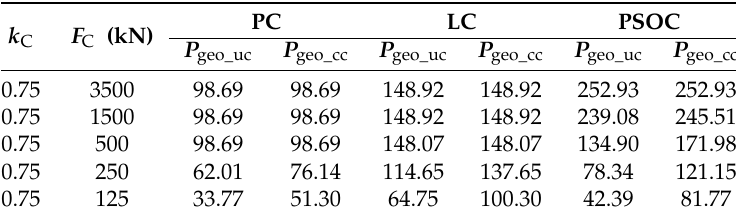
Table 2. Average absorbed power (kW) for various constrained control strategies with geometries that are designed with unconstrained control ( P geo_uc ) and geometries that are designed with constrained control ( P geo_cc